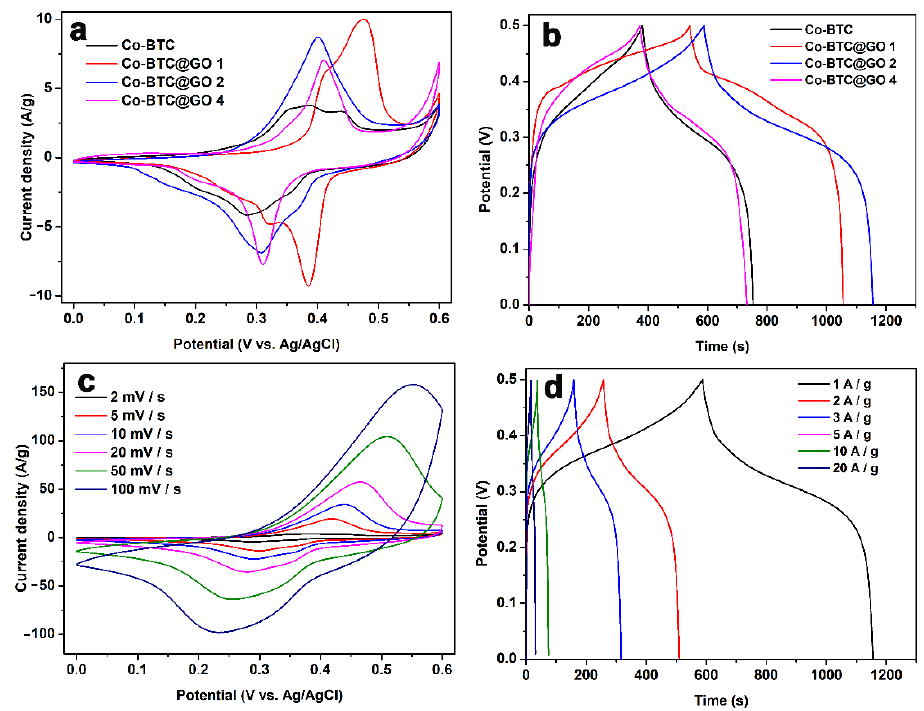
Figure 6. ( a ) CV curves for Co-BTC and Co-BTC@GO composites at 2 mV/s; ( b ) GCD curves for Co-BTC and Co-BTC@GO composites at 1 A/g; ( c ) CV curves for Co-BTC@GO 2 at 2 – 100 mV/s; ( d ) GCD curves for Co-BTC@GO 2 at 1 – 20 A/g. Table 1. Comparison of the electrochemical performance of similar MOF@GO composites reported in the literature.